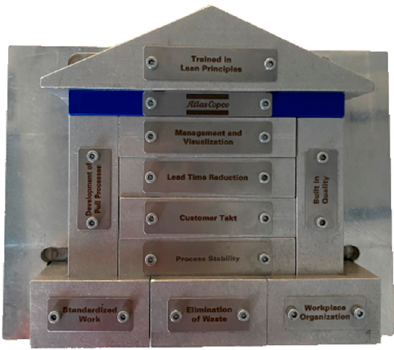
Figure 2. Completed assembly.